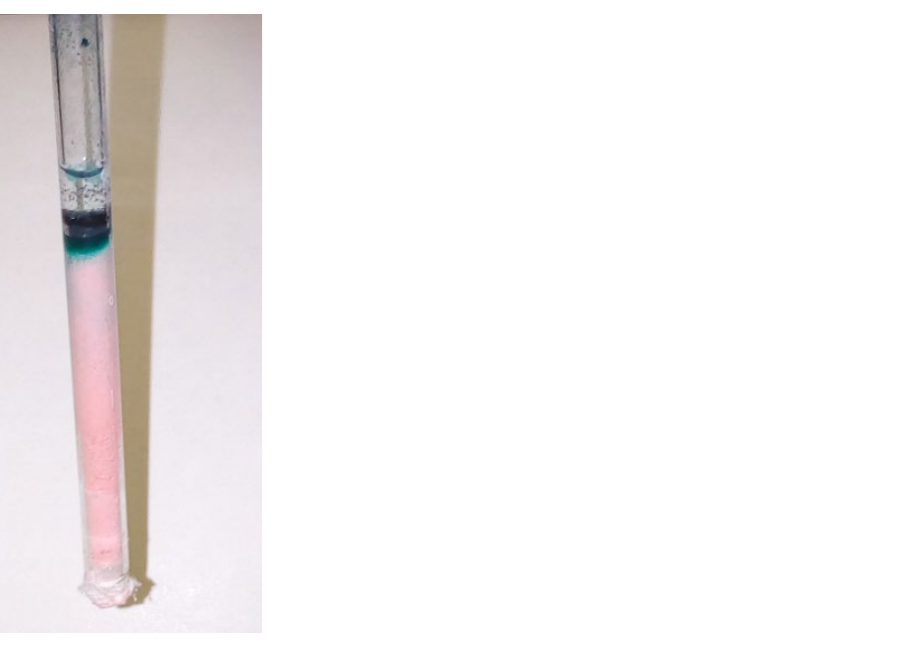
Figure 18. Selective separation of a mixture of dyes (methylene blue, malachite green, and Congo red) on a column filled with the studied sorbent.